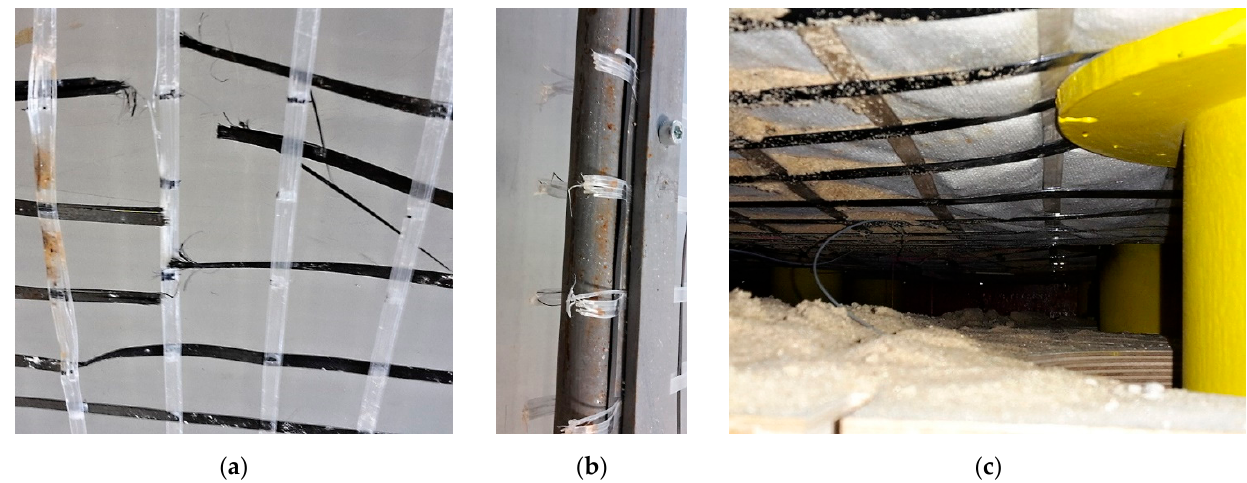
Figure 9. Geogrid breakage after overload ( a ), fixation problem on the edges ( b ), detail of pile support and basal reinforce- ment layer reinforced by geogrid and geotextile ready for testing ( c ).